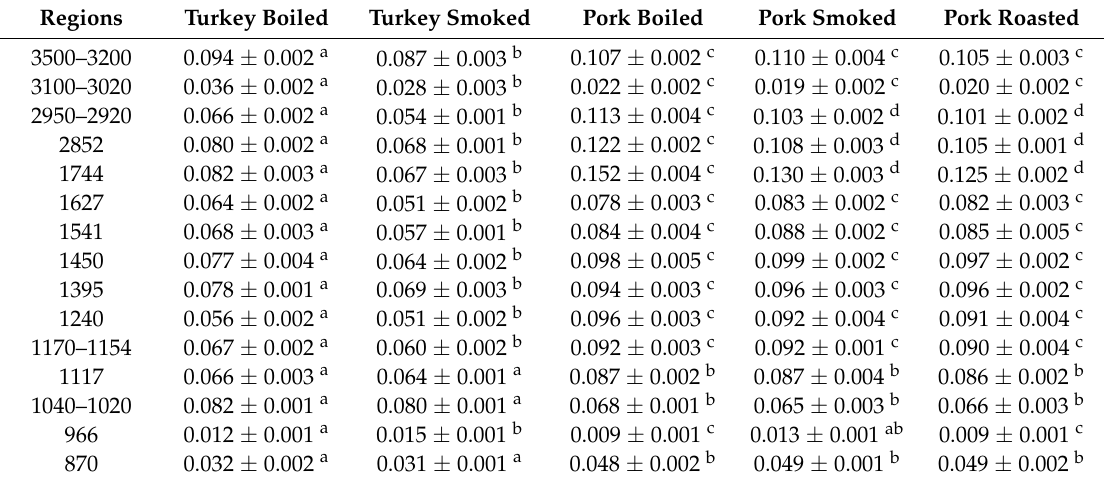
Results represent means ± standard deviation ( n = 30). Different letters after each value in the same row indicate statistically significant differences ( p <